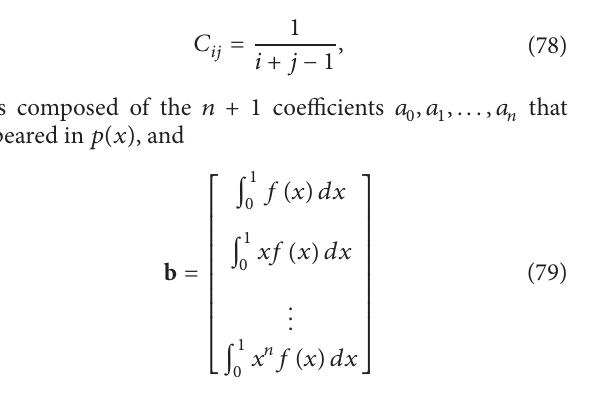
Figure 1: Example 1 showing (a) residual, ((b) and (c)) optimal parameters, and (d) steplength and 𝑎 0 .